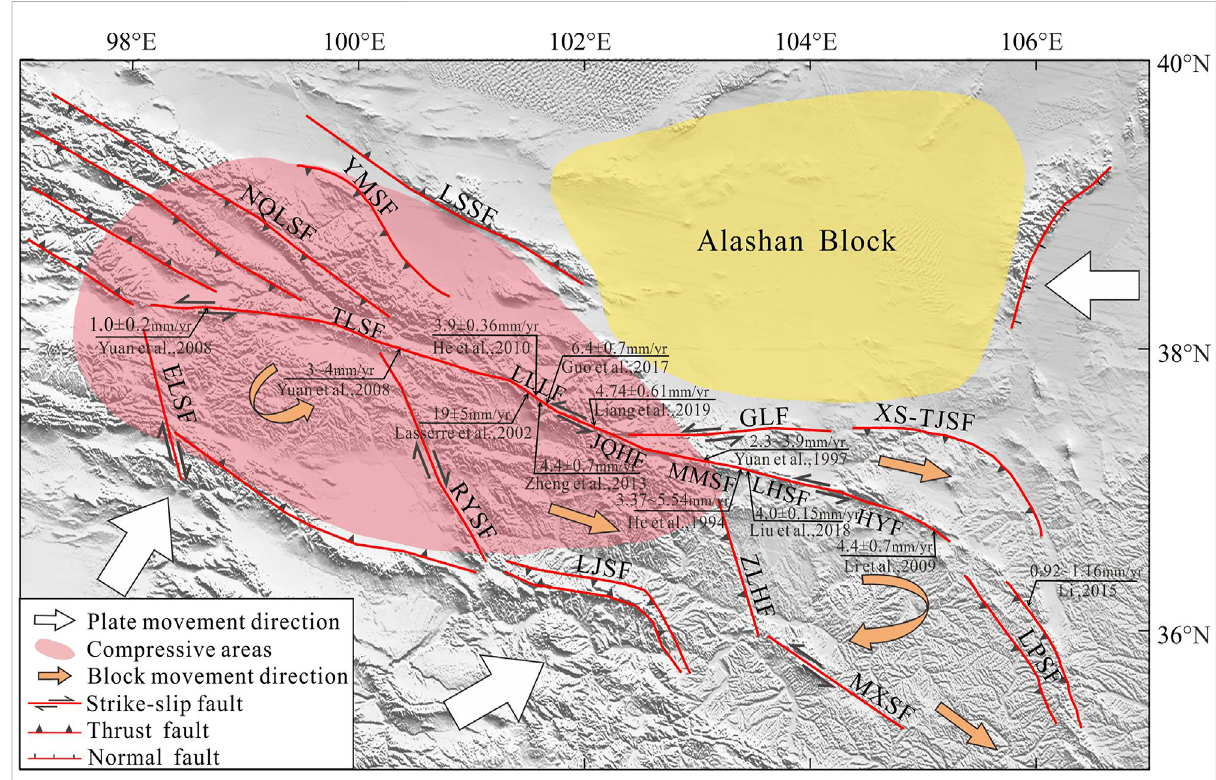
FIGURE 10 Tectonic transformation pattern in the northeastern margin of the Tibetan Plateau (modi fi ed from Yuan et al. (2004) and Zheng et al. (2013)). Red lines represent fault lines. White arrows represent the plate movement direction. Orange arrows represent the block movement direction. Pink shadow represents the compressive area. Yellow shadow represents the blocking area. LSSF: Longshoushan fault; YMSF: Yumushan fault; NQLSF: Northern Qilian Shan fault; TLSF: Tuolaishan fault; LLLF: Lenglongling fault; JQHF: Jinqianghe fault; MMSF: Maomaoshan fault; LHSF: Laohushan fault; HYF: Haiyuan fault; GLF: Gulang fault; XS – TJSF: Xiangshan – Tianjingshan fault; LPSF: Liupanshan fault; ELSF: Elashan fault; RYSF: Riyueshan fault; LJSF: Lajishan fault; ZLHF: Zhuanglanghe fault; MXSF: Maxianshan